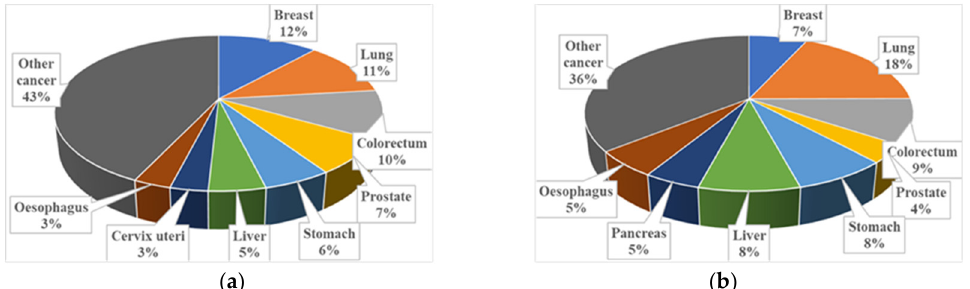
Figure 1. Pie chart showing different types of cancer in 2020 for ( a ) new cases and ( b ) deaths in the world. Data from [1].